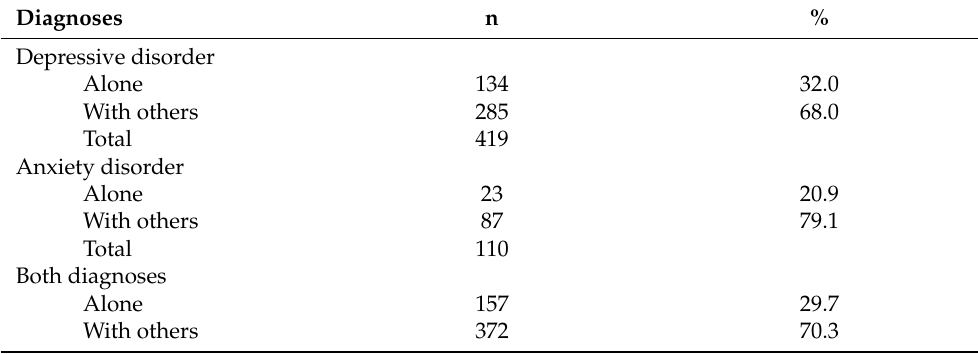
Table 5. Living conditions of patients >65 years ( n = 529).